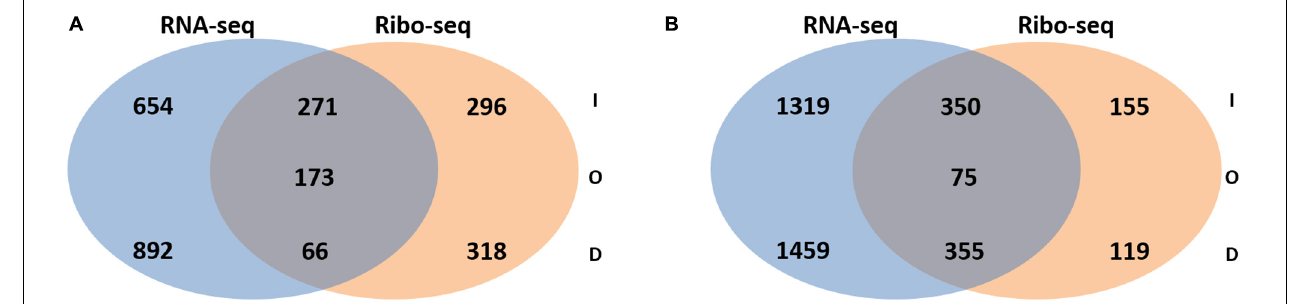
FIGURE 2 | Venn diagram showing the number of transcripts with increased (I), decreased (D) or opposite (O) abundance in RNA-seq and Ribo-seq data obtained after (A) colistin treatment and (B) tobramycin treatment. For significance, only transcripts with a fold-change ≥ 2 or ≤ –2 and a multiple testing adjusted p -value ≤ 0.05 were considered. The corresponding transcripts and ribosomal footprints with increased, decreased and opposite abundance are listed in Supplementary Table 1